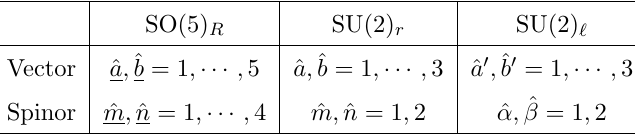
Table 3 . R-symmetry